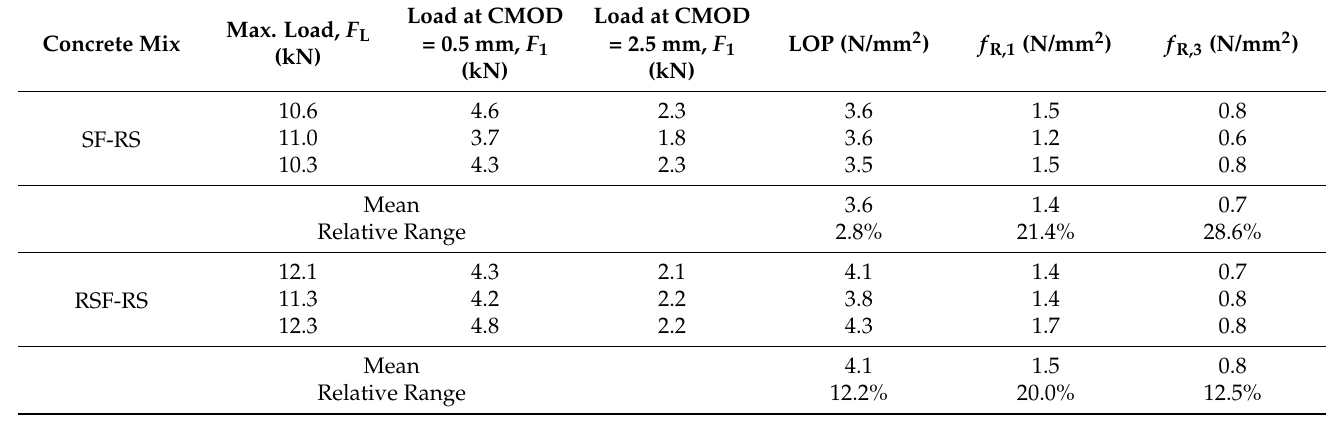
Table 6. Flexural residual strength according to EN 14651 [58].